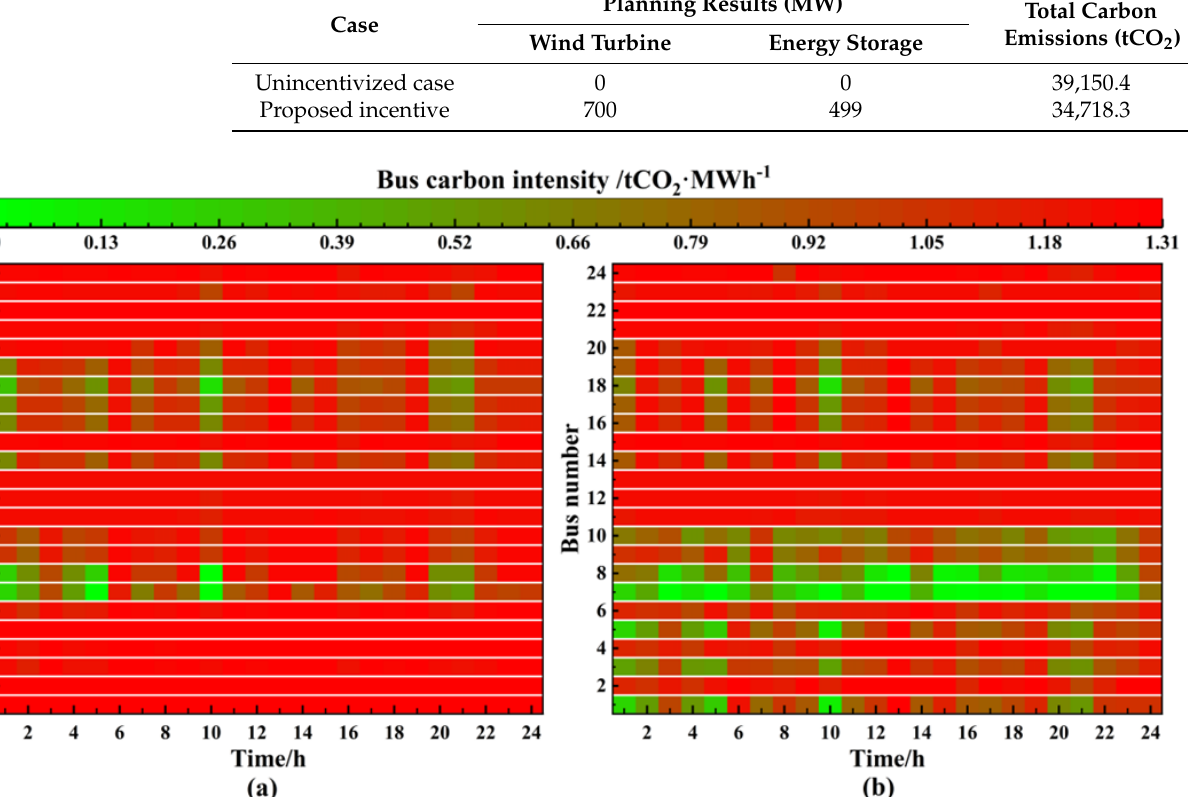
Figure 6. Bus carbon intensities at optional WT locations before planning.